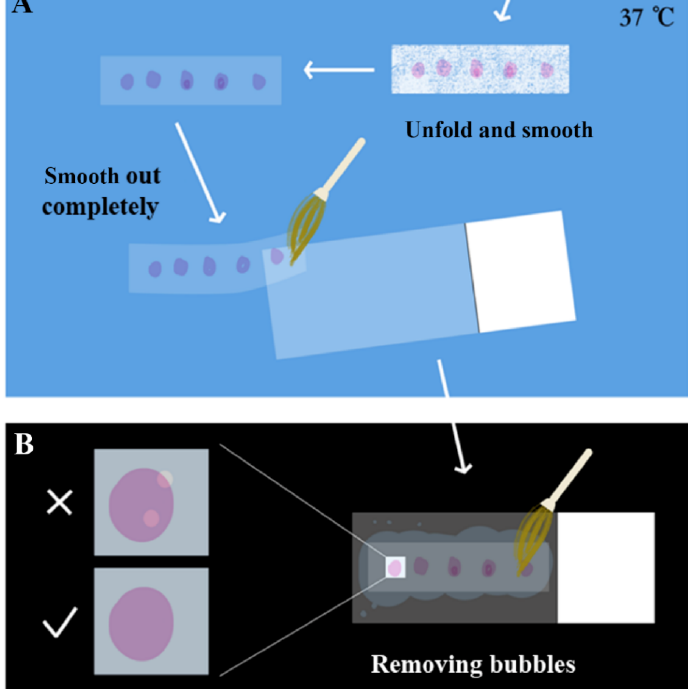
Figure 4. Schematic tips of the optimized process of unfolding and smoothing sections. ( A ) The sections softened and smoothed out with paraffin completely, until the color changed from white to almost transparent. Then, the section was smoothed out again gently with a brush on the slide. ( B ) Pressed lightly with the brush to drive off the air bubbles, and then absorbent paper was used to gently absorb the water to reduce the drying time and improve the effect of drying, avoiding the separation of the sample from the slide later.